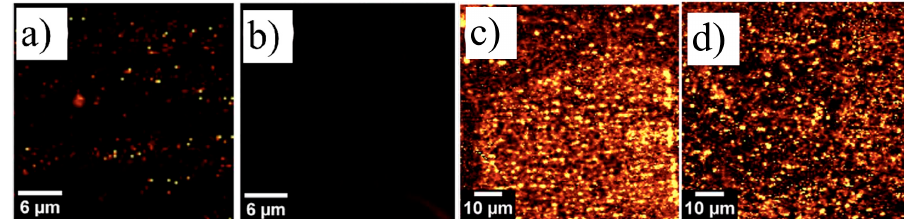
Figure 8. Raman mapping of graphene: CVD-grown ( a ) single-layer graphene on Cu; and ( b ) few-layer graphene on Ni foam. Wet transferred ( c ) single-layer grapheme; ( d ) bilayer graphene on SiO 2 substrate. The bright spots represent the defect sites on graphene lattice. The transferred graphene exhibits higher defect density compared to in-situ grown graphene. Adapted with permission from ref. [18] under Creative Commons Attribution 4.0 International License.